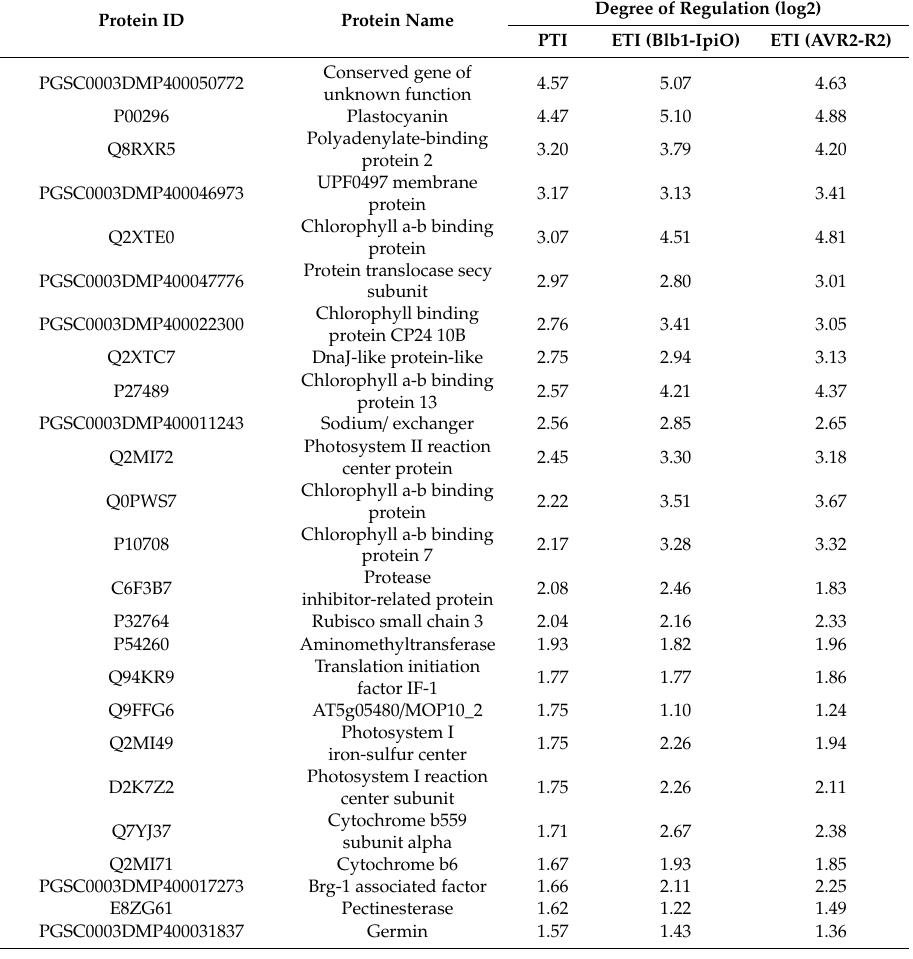
Table 1. Proteins with increased abundance from PTI and two ETI interactions, 18 hpi (hours post infiltration). A comparison was made between the immune-treated plants and the control plants infiltrated with medium only. All values are in log2 fold. Non-significant p values are indicated by NA. All p -values < 0.01 are shown in the